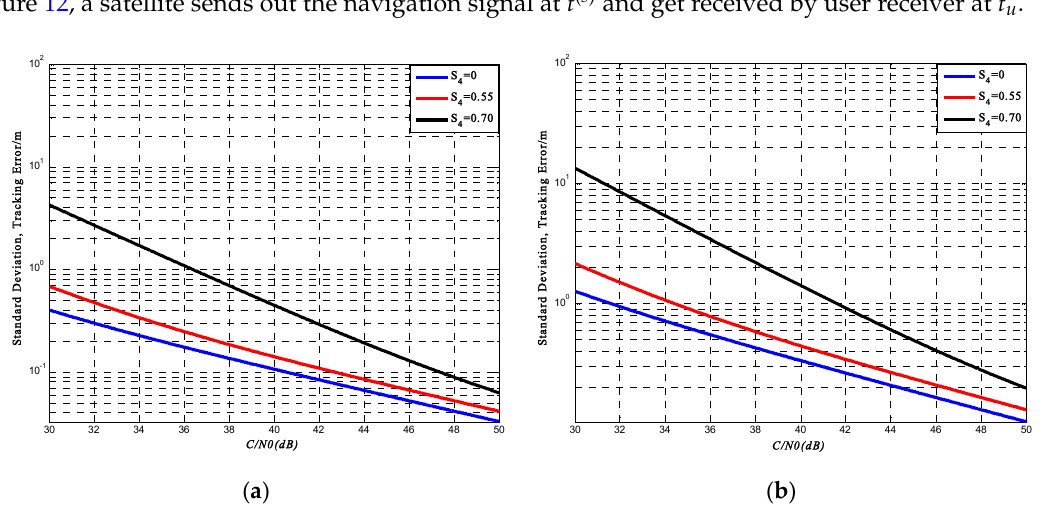
Figure 11. ( a ) BeiDou PN code tracking error ( d = 1); ( b ) BeiDou PN code tracking error ( d = 0.1).